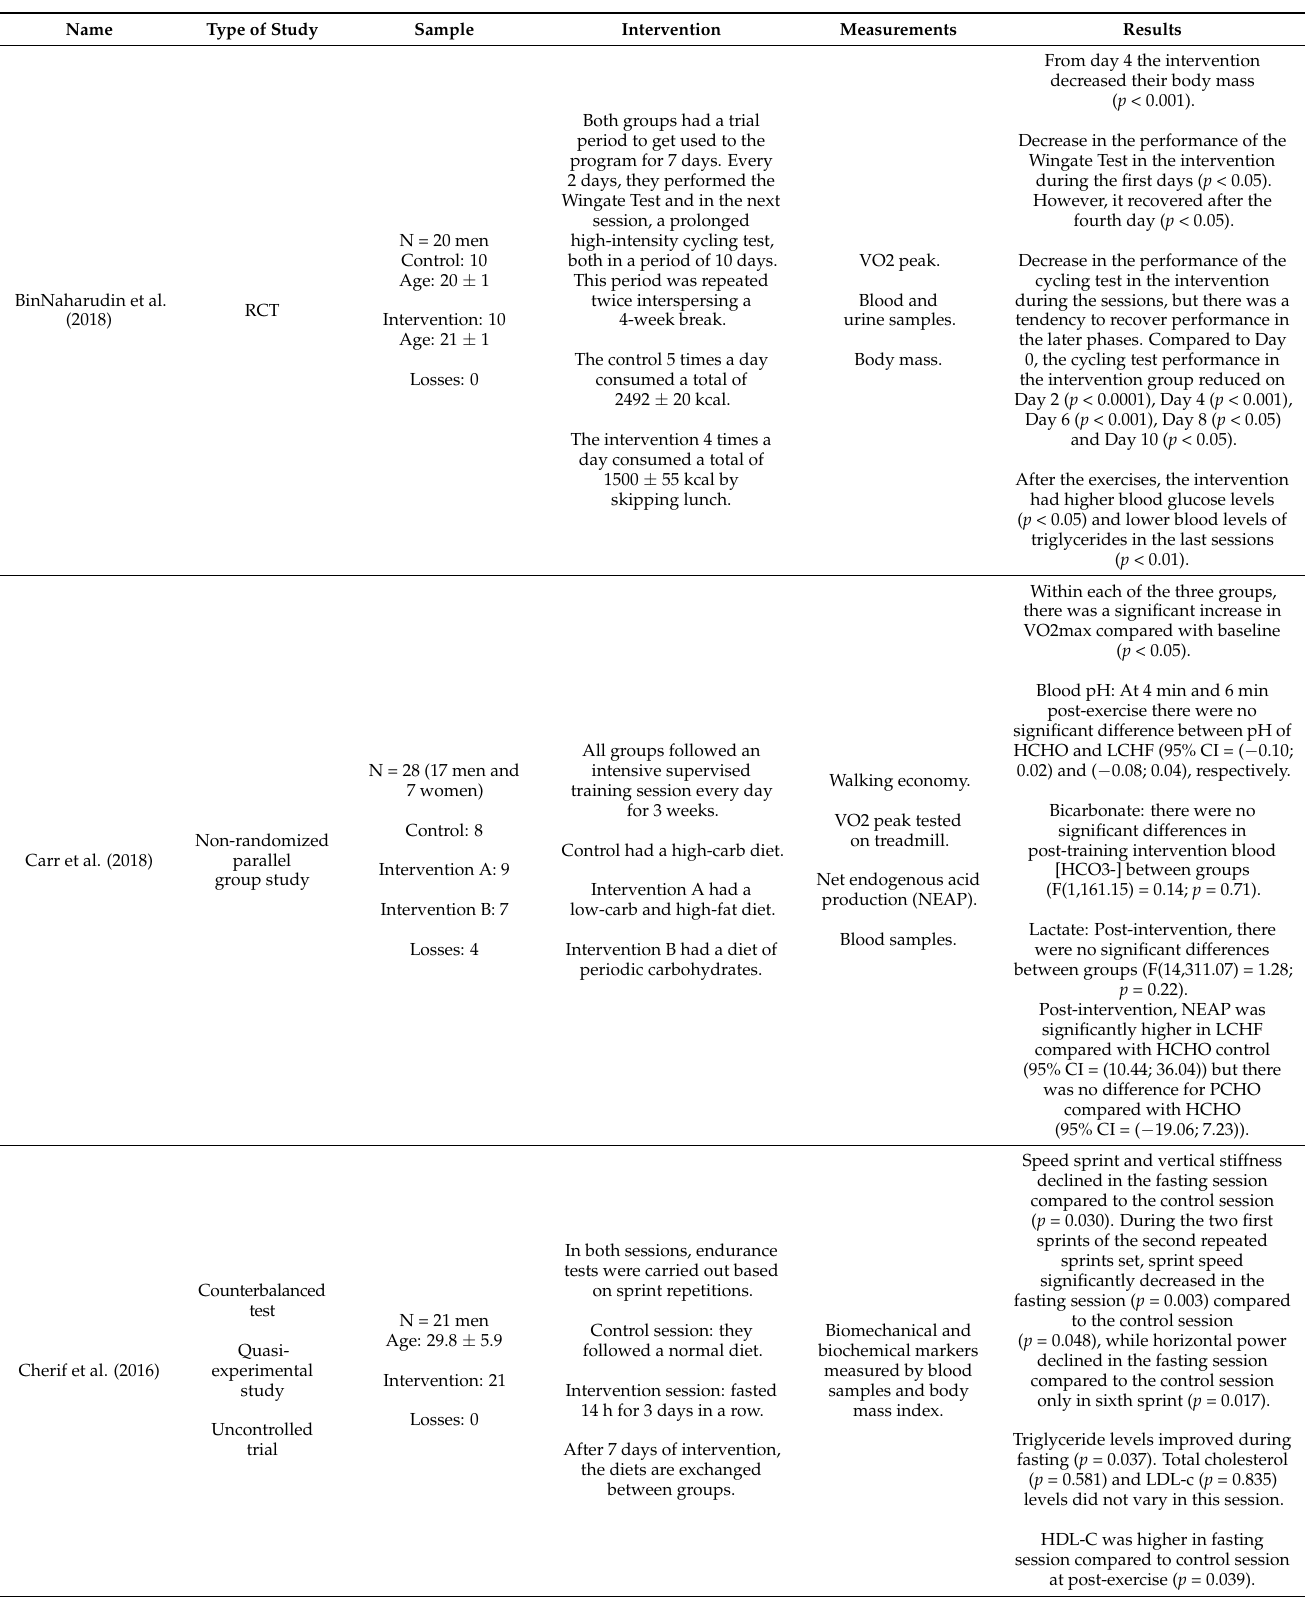
Table 6. Characteristics of the selected